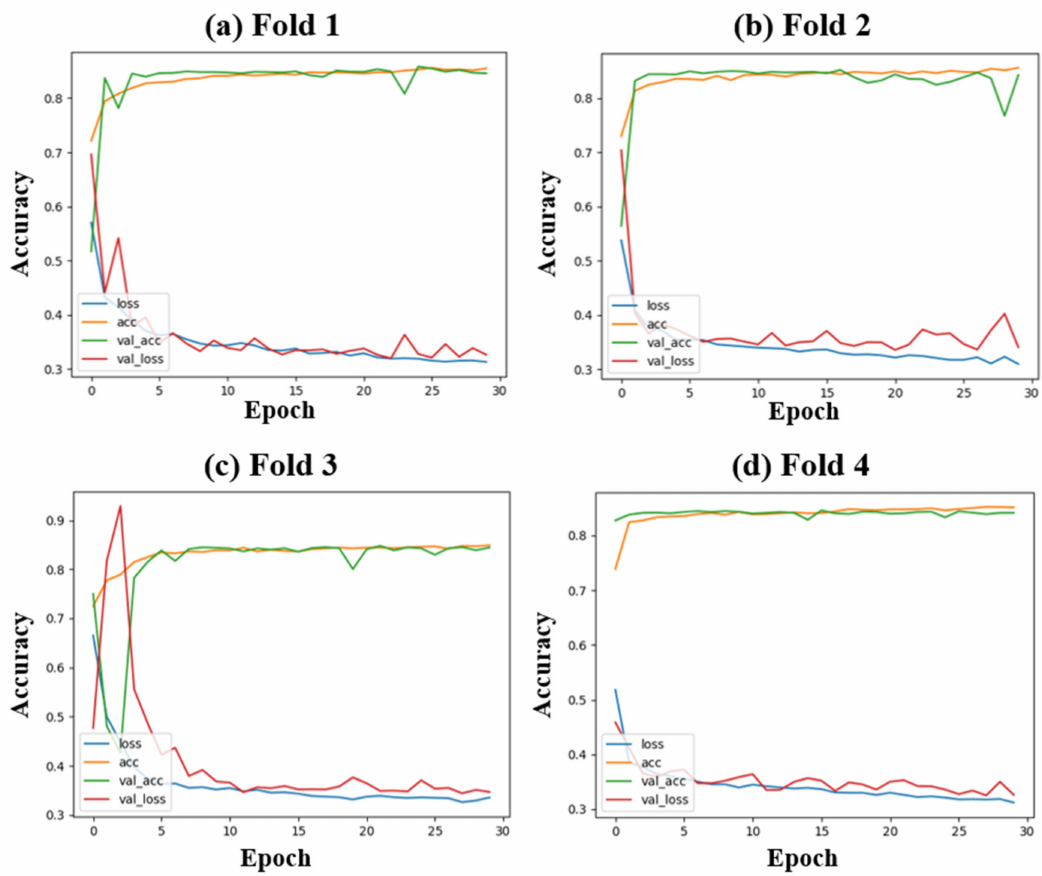
Figure 9. Performance of the RadRGB model on each fold.